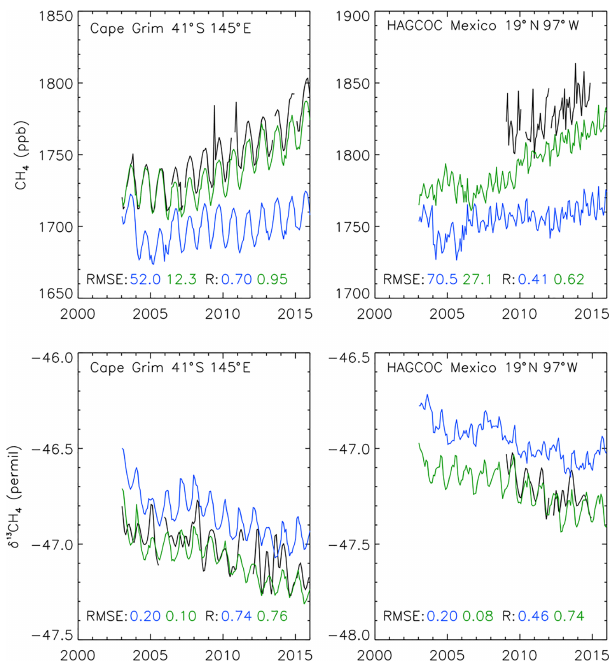
Figure 5. Observed surface CH 4 (top) and δ 13 CH 4 (bottom) from 2003 to 2015 at two independent NOAA sites (black line). Also shown are results from TOMCAT simulations using prior emis- sions estimates (blue line), and posterior estimates based on a com- bined CH 4 and δ 13 CH 4 synthesis inversion (INV-FULL, green line). RMSE and correlation coefficients of the model simulations compared with observations are shown for each